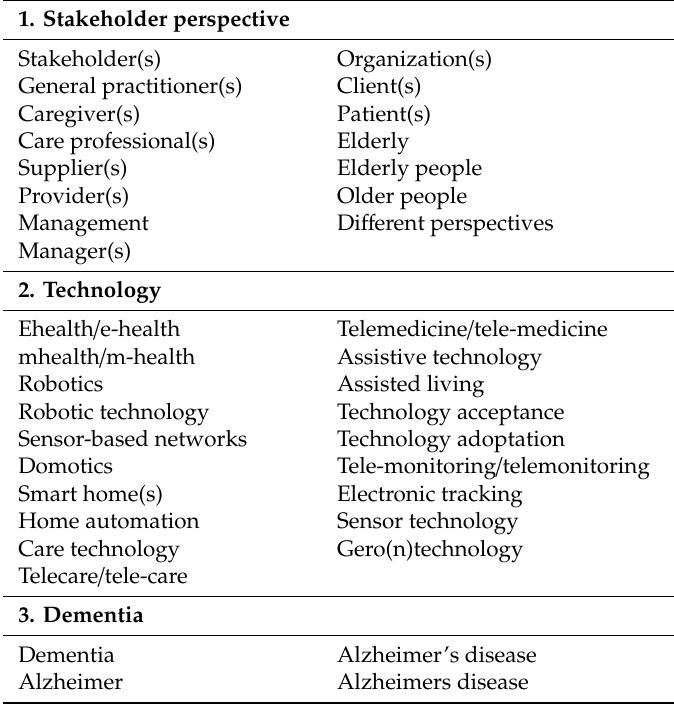
Table 1. Groups of search